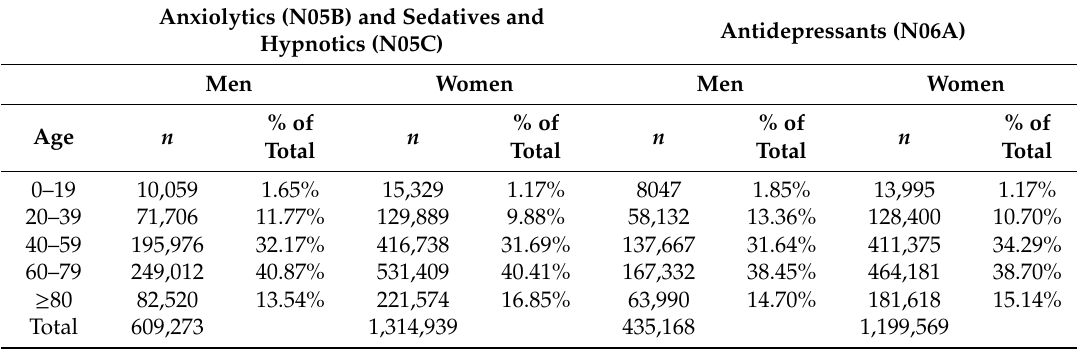
Table 1. Anxiolytics, sedatives, hypnotics and antidepressants dispensed by age and sex in Portugal. Anxiolytics (N05B) and Sedatives